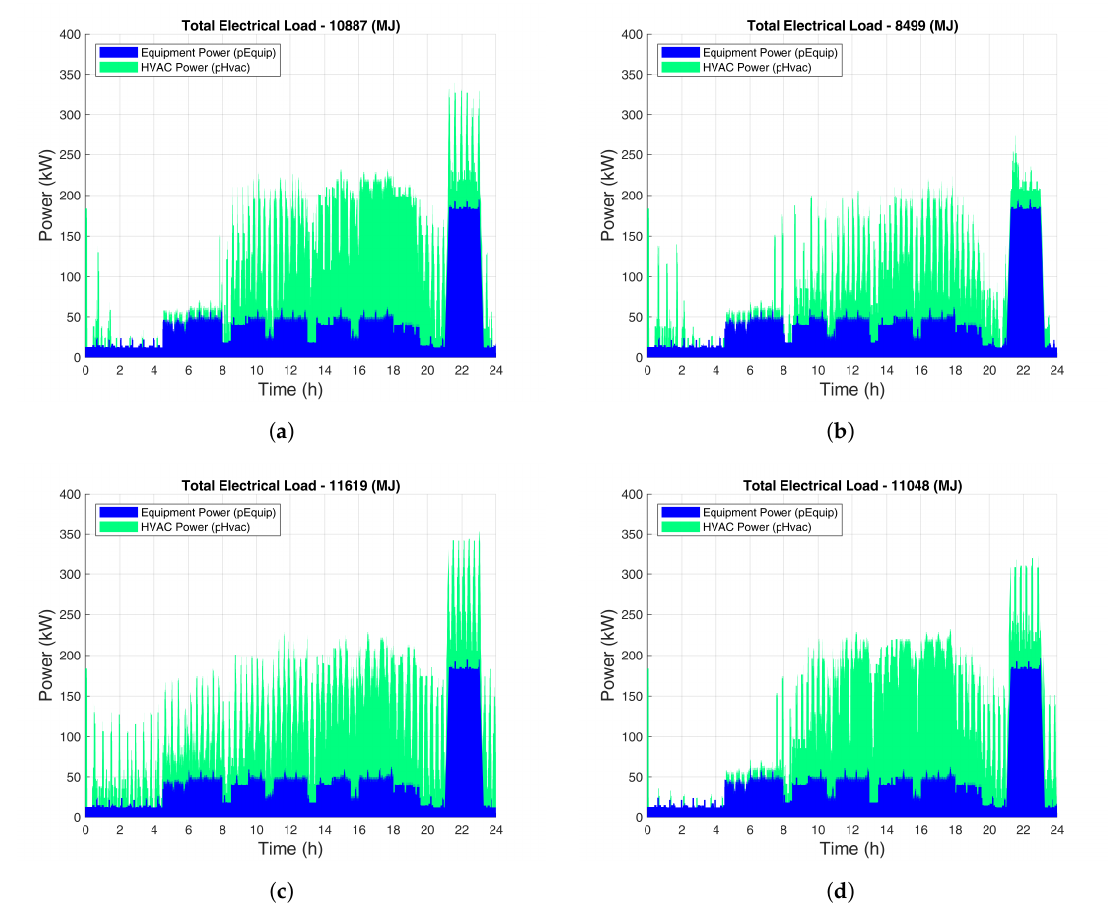
Figure 6. The electrical load, which depends on atmospheric conditions. ( a ) The electrical load subject to the clear sky solar radiation and temperature profiles. ( b ) The electrical load subject to the partly cloudy sky solar radiation and temperature profiles. ( c ) The electrical load subject to the overcast sky solar radiation and temperature profiles. ( d ) The electrical load subject to the monsoon sky solar radiation and temperature